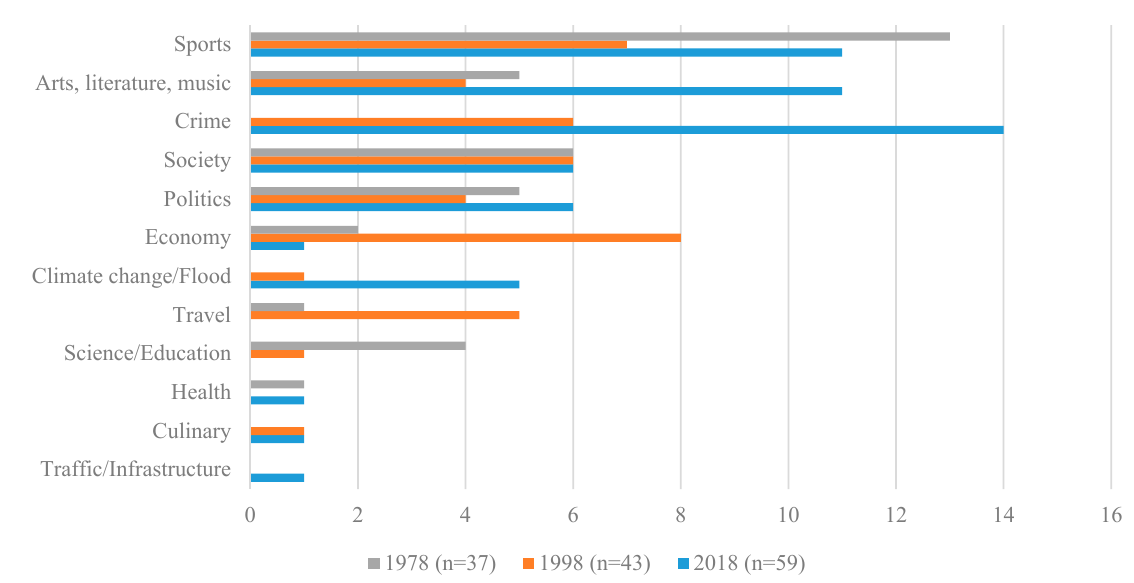
Figure 11. Keyword search for “Baton Rouge” in the NYT (New York Times) online archive for the years 1978, 1998, and 2018 by category and year in absolute numbers; accessed in May 2019.